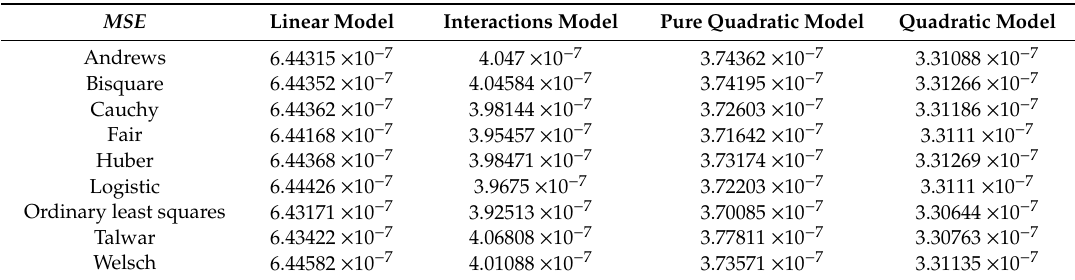
Table 5. The MSE of combination models of four kinds of model specification parameters and nine kinds of robust weight